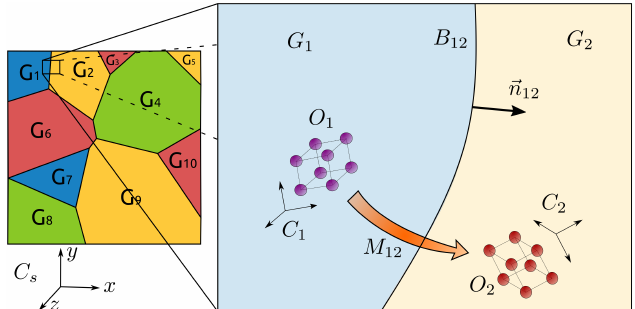
Figure 1. Scheme depicting one GB and its parameters. Image available online at Flickr (https: //flic.kr/p/2m5JQkz, accessed on 15 June 2021) licensed under CC BY 2.0 (https://creativecommons. org/licenses/by/2.0/, accessed on 15 June 2021). Title: 10GGBParam. Author: Brayan